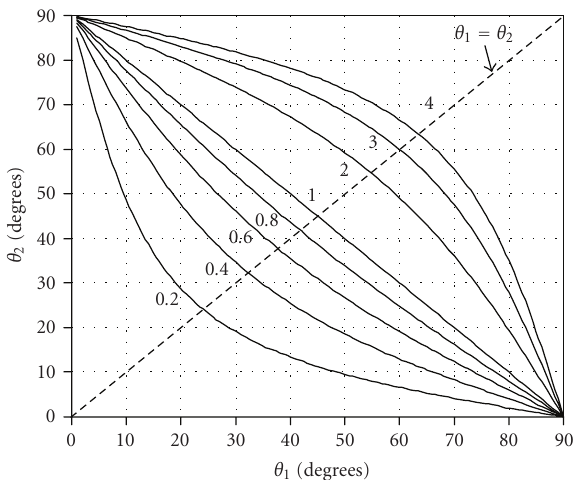
Figure 5: θ 1 versus θ 2 for di ff erent values of K .